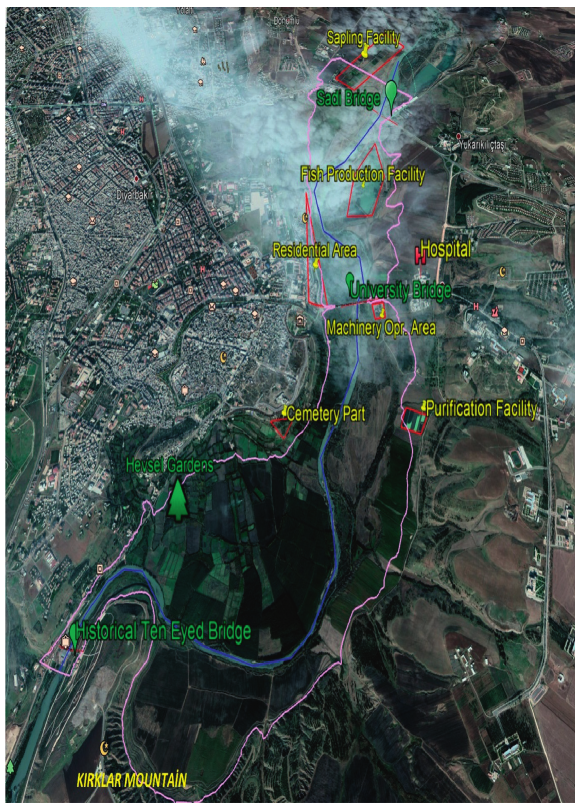
Figure 10: Flood boundary with HEC-RAS ( Q